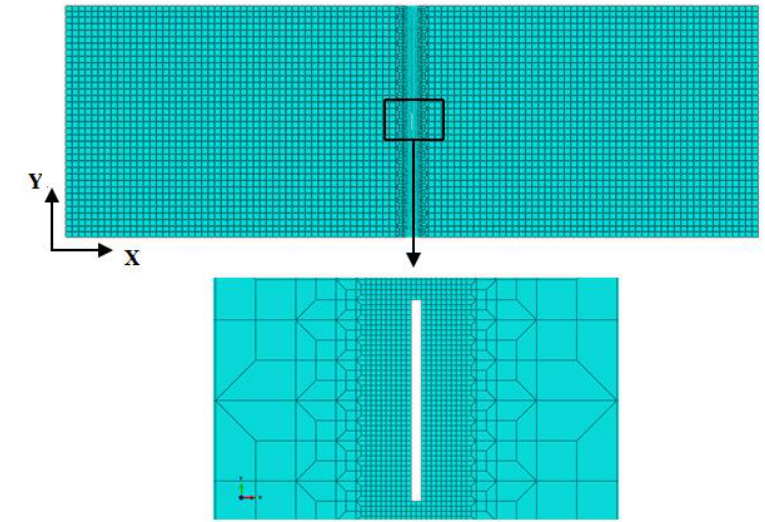
Figure 3. Finite element model.